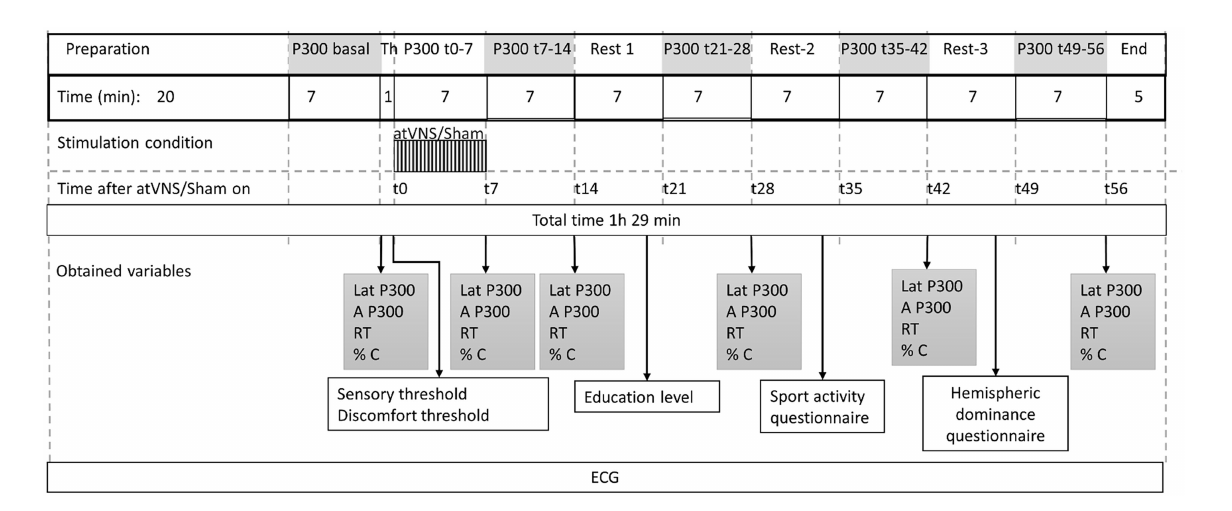
FIGURE 3 Stimulating protocol sequence. 12 consecutive periods with their respective duration are shown. Time 0, was considered at the beginning of taVNS or sham stimulation. Variables obtained along the periods are shown. Time ( t ) in minutes. Latency (Lat), Amplitude (A), Reaction time (RT), accuracy (% C) % of target sounds correctly indicated, Th, Threshold; ECG,